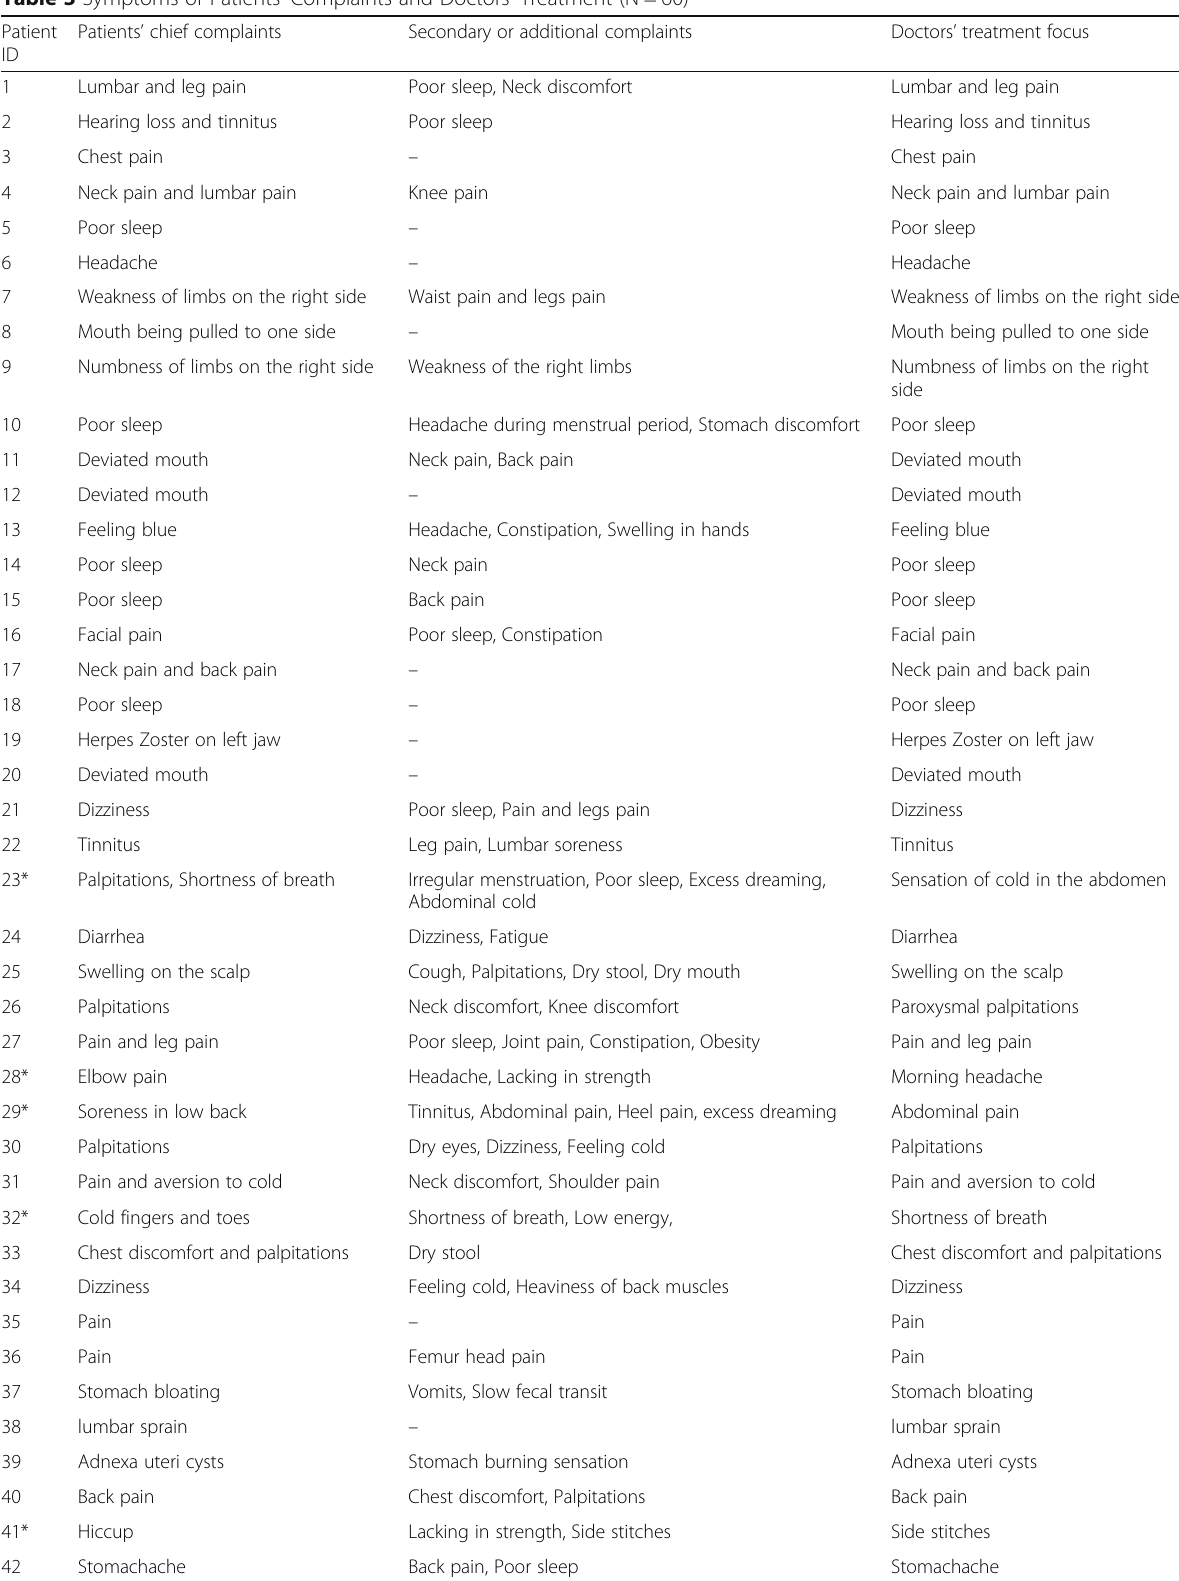
Table 3 Symptoms of Patients ’ Complaints and Doctors ’ Treatment (N = 60) Patient